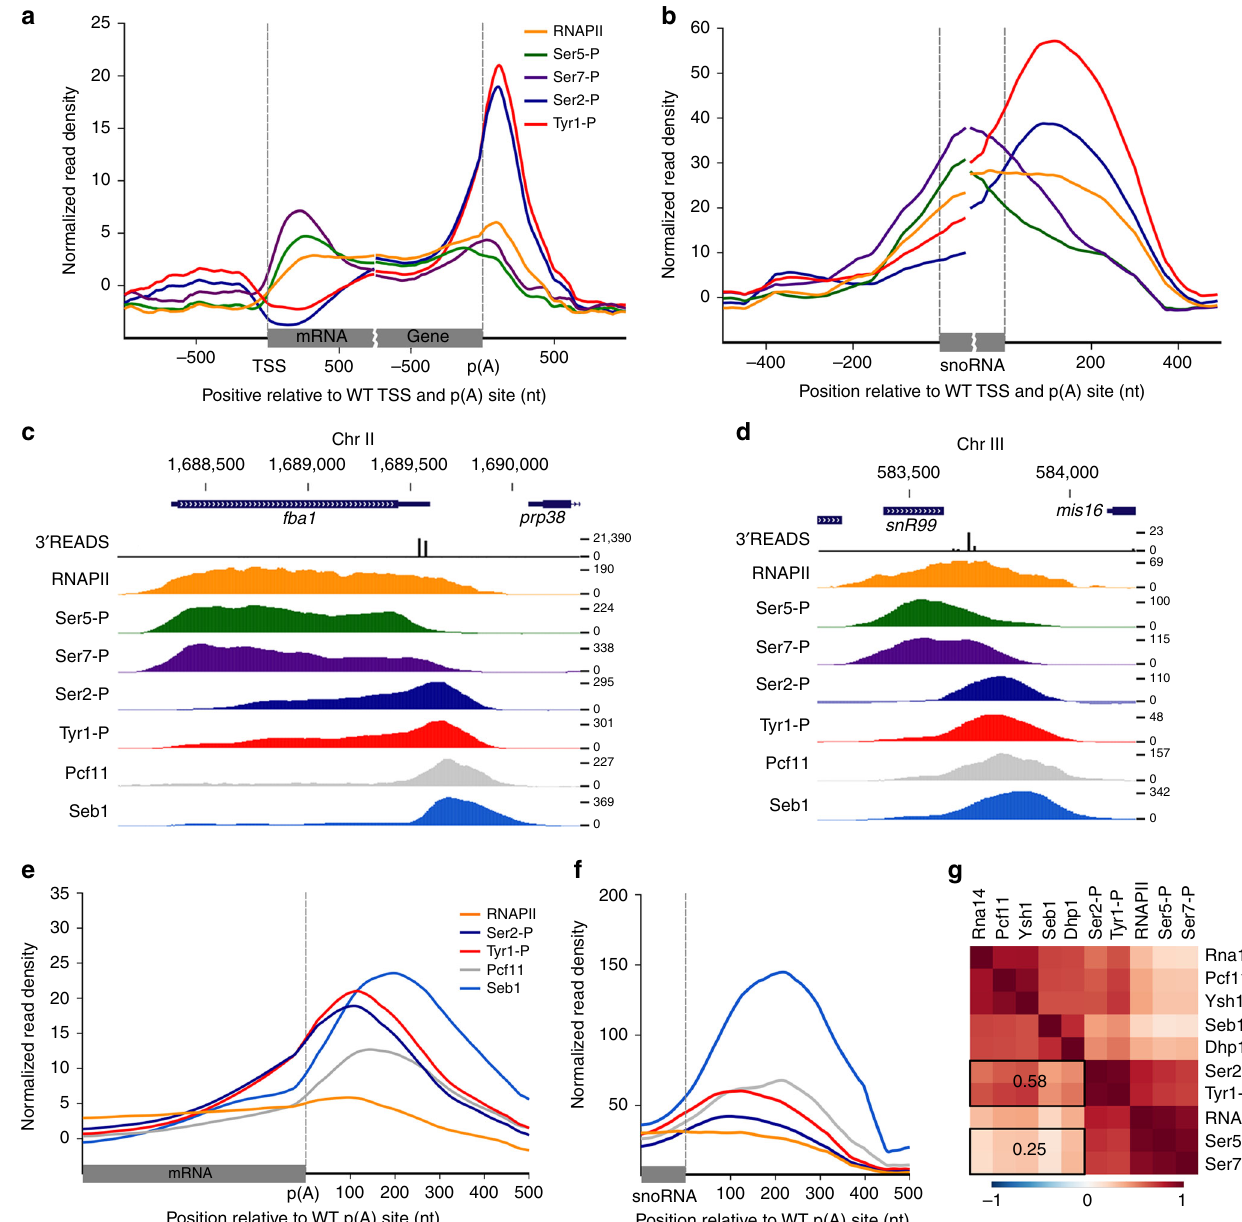
Fig. 4 Tyr1-P and Ser2-P forms of the RNAPII CTD colocalize with 3 ′ end processing factors at coding and ncRNA genes. a , b Average ChIP-seq pro fi le of total RNAPII (Rpb1) and the indicated CTD modi fi cations in a WT strain across 4755 mRNAs ( a ) and 24 monocistronic snoRNAs ( b ) with a mapped poly (A) site in minimal medium. c , d PAS read density (3 ′ READS) and normalized ChIP-seq signal of total RNAPII (Rpb1), the indicated CTD modi fi cations, as well as Pcf11 and Seb1 across the fba1 mRNA ( c ) and the snR99 snoRNA ( d ) genes. e , f Average pro fi le of total RNAPII (Rpb1), Ser2-P, Tyr1-P, Pcf11, and Seb1 relative to the poly(A) site of 4755 mRNA ( e ) and 24 monocistronic snoRNA ( f ) genes in minimal medium. g Genome-wide pairwise Pearson correlation coef fi cient matrix at a resolution of 10 bp followed by a hierarchical clustering. Rectangles include the average of a subset of correlation values between 3 ′ processing factors and CTD modi fi cations RNAPII component (Rpb3-HA; Fig. 5a – c). Importantly, tran- scription termination defects are a general feature of Dhp1- de fi cient cells, as seen by a clear shift in the Rpb1 and Rpb3-HA average signals downstream of the noticeable decline observed in wild-type cells (Fig. 5d, e; compare solid and dotted lines). These results show that Dhp1 is required for RNAPII termination at both coding and ncRNA genes.